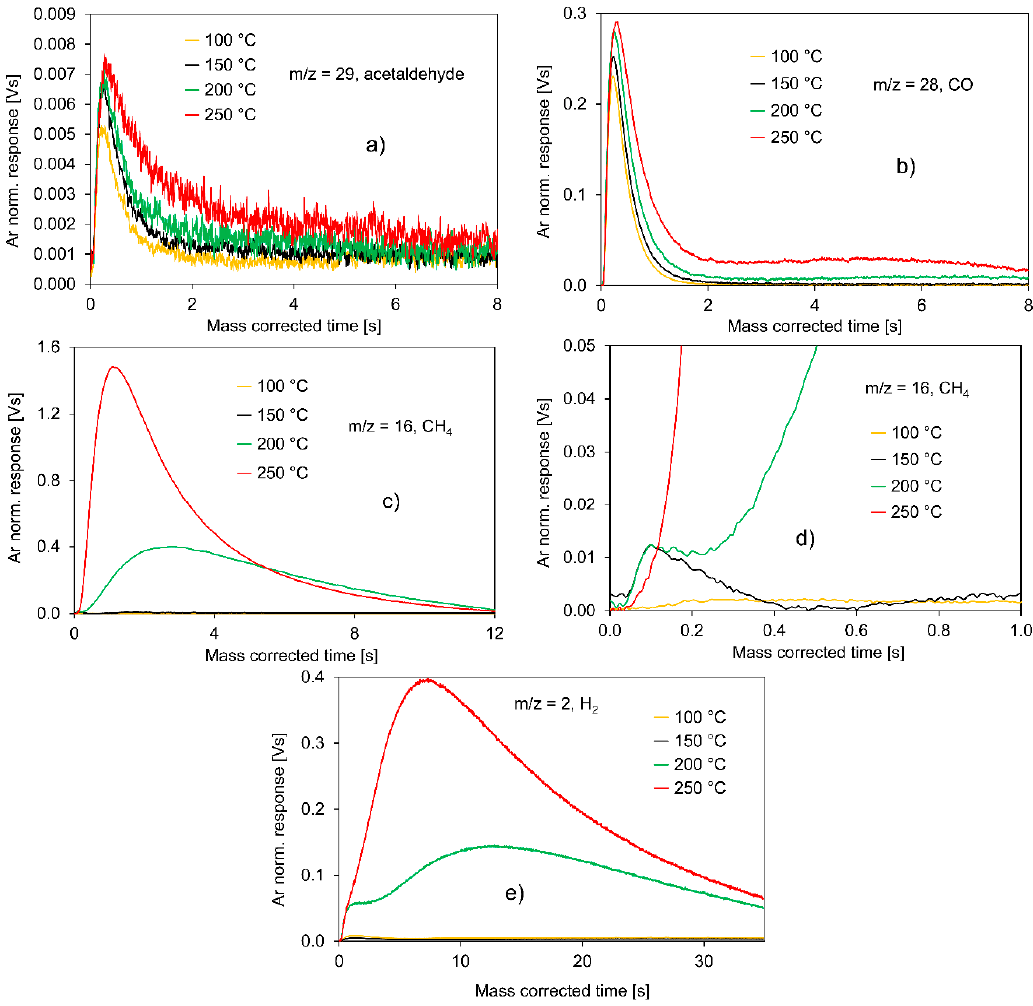
Figure 7. Ar-normalized transient responses to pulses of 34.6 vol % ethanol in Ar at temperatures between 100 °C and 250 °C on the H 2 pre-reduced Pt/C catalyst (20 mg), ( a ) the m/z-value of 29 for acetaldehyde; ( b ) the m/z-value of 28 for CO; ( c ) the m/z-value of 16 for CH 4 ; ( d ) the magnification of ( c ); ( e ) the m/z-value of 2 for H 2 .